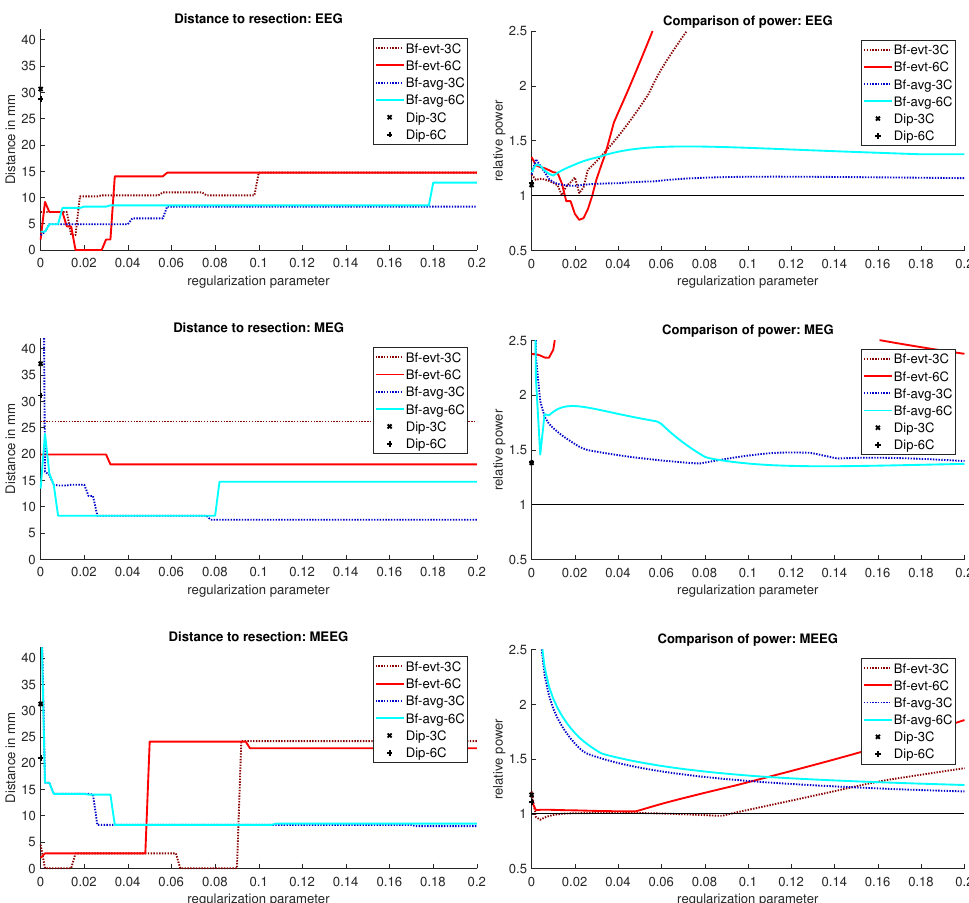
Figure 9. Localization results for patient 2. The distance of the localization of the beamformer maximum to the resection volume for each regularization value from 0 to 0.2 in steps of 0.002 is shown on the left. The corresponding power relation, which is the maximum power outside the resection volume divided by the maximum inside, is depicted on the right. Each pair of graphs is specific to one modality: EEG, MEG, and MEEG, from top to bottom. The methods are color coded in the same way for all modalities: lighter colors and full lines are used for the 6 compartment, darker dotted lines for the 3 compartment model.